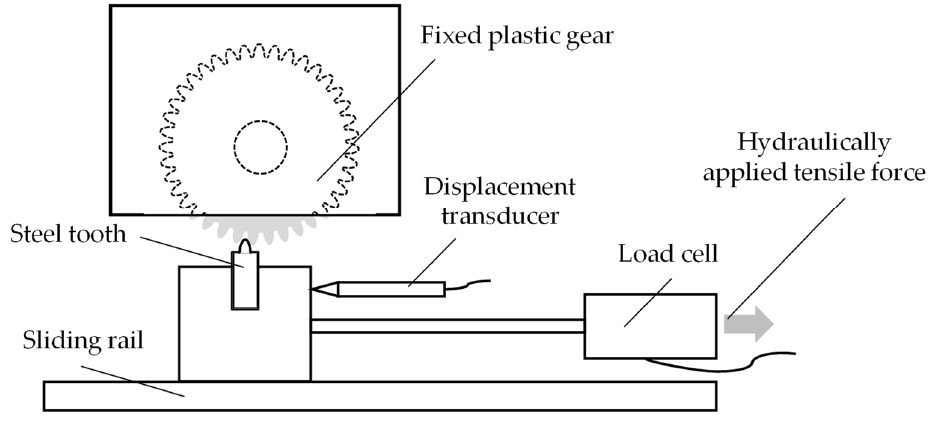
Figure 4. Pulsator test rig for the measurement of the elastic tooth deformation.